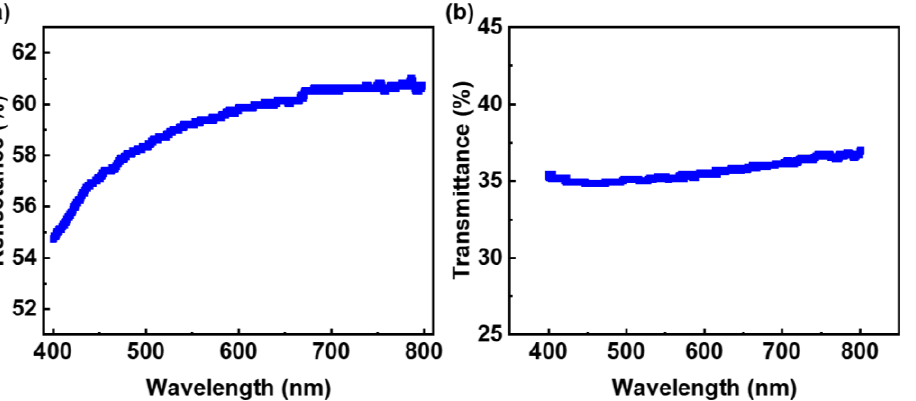
Figure 4. ( a ) The reflectance and ( b ) transmittance of homemade numbered 8015 conductive Ag paste